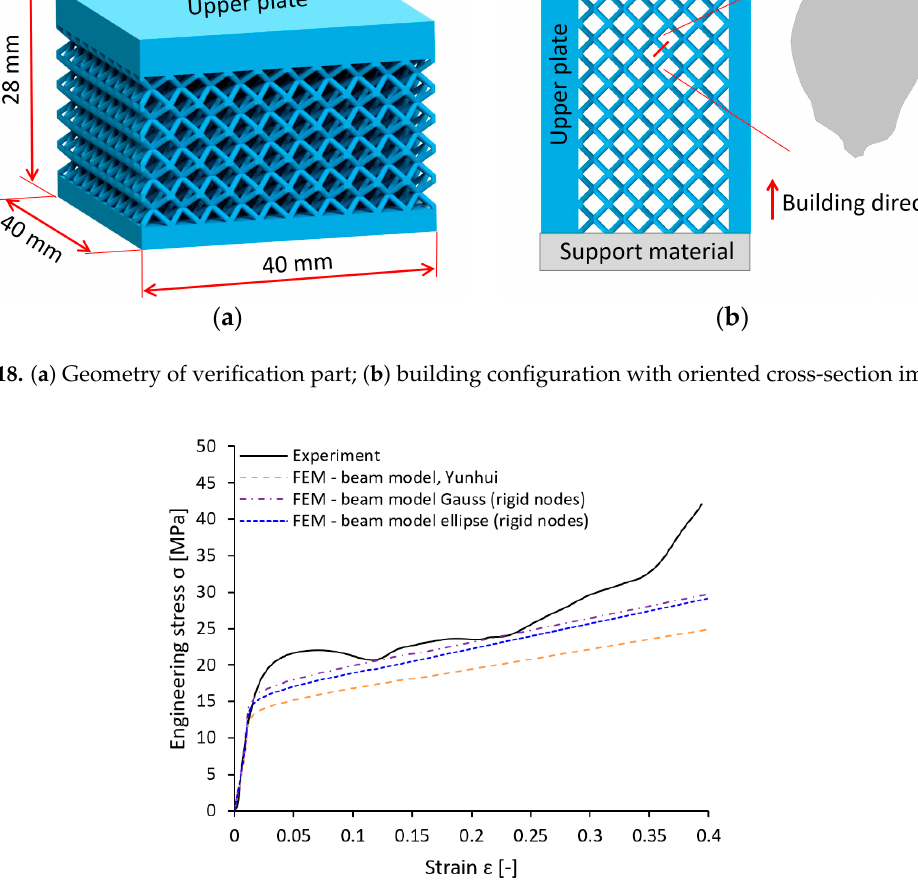
Figure 19. Engineering stress-strain comparison of reference structured part.